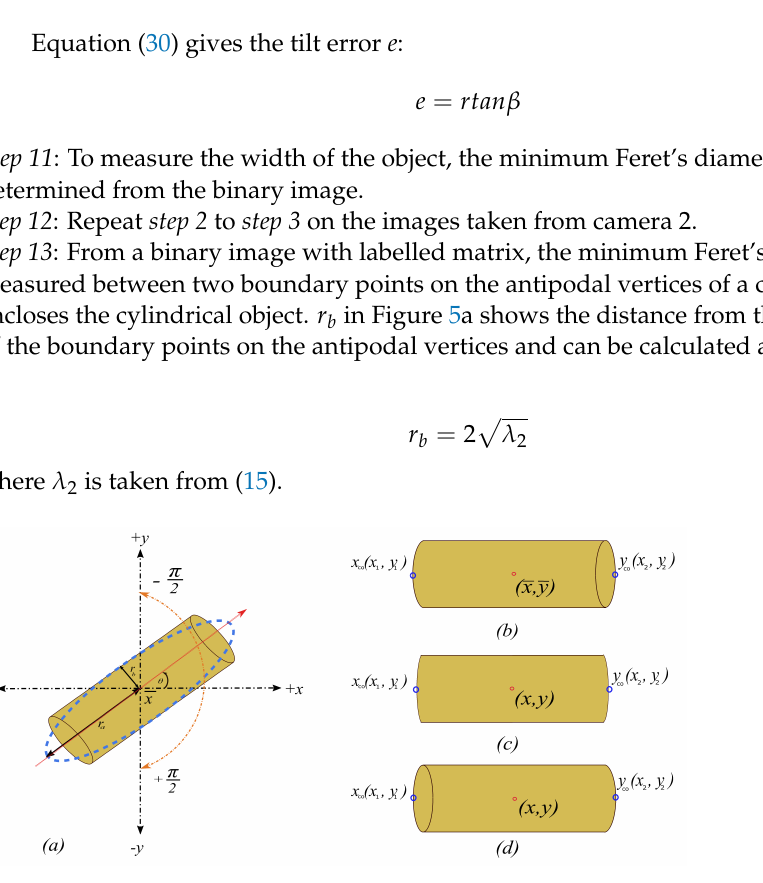
Figure 5. ( a ) Region orientation, with the major axis of the region passing through the centroid( x , y ) with orientation θ [13]. The x and y are the co-ordinates of a line segment of the binary image with high intensity values. Perspective errors can also be seen when the object is viewed from the ( b ) top FOV ( c ) centre FOV, and ( d ) bottom